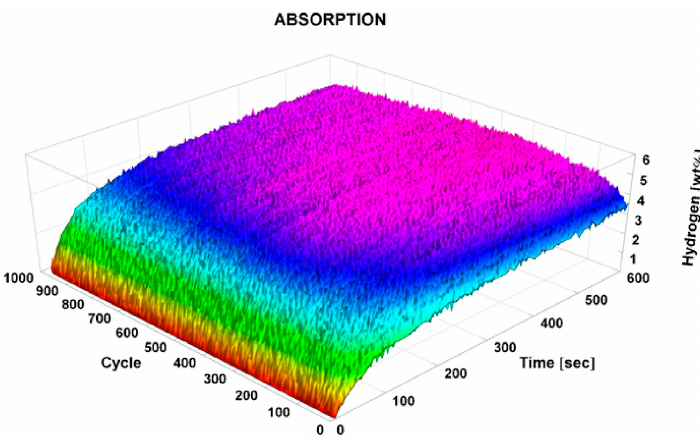
Figure 5. Color-coded 3D diagrams showing the storage capacity and kinetics of hydrogen at the absorption of ZK60 at 623 K against cycle number and time. Reproduced with permission from [24], Elsevier, 2011.